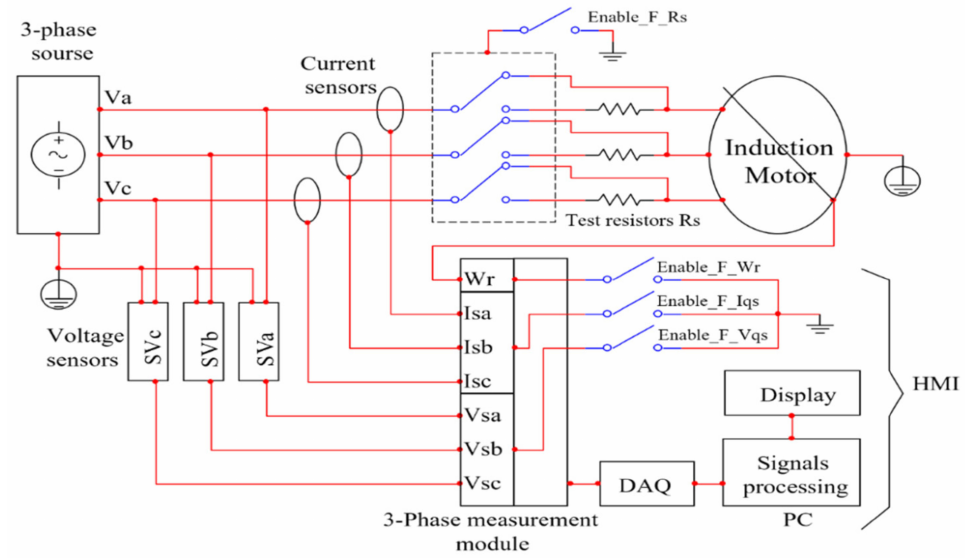
Figure 7. Block diagram of proposed experimental scheme for 3PIM fault